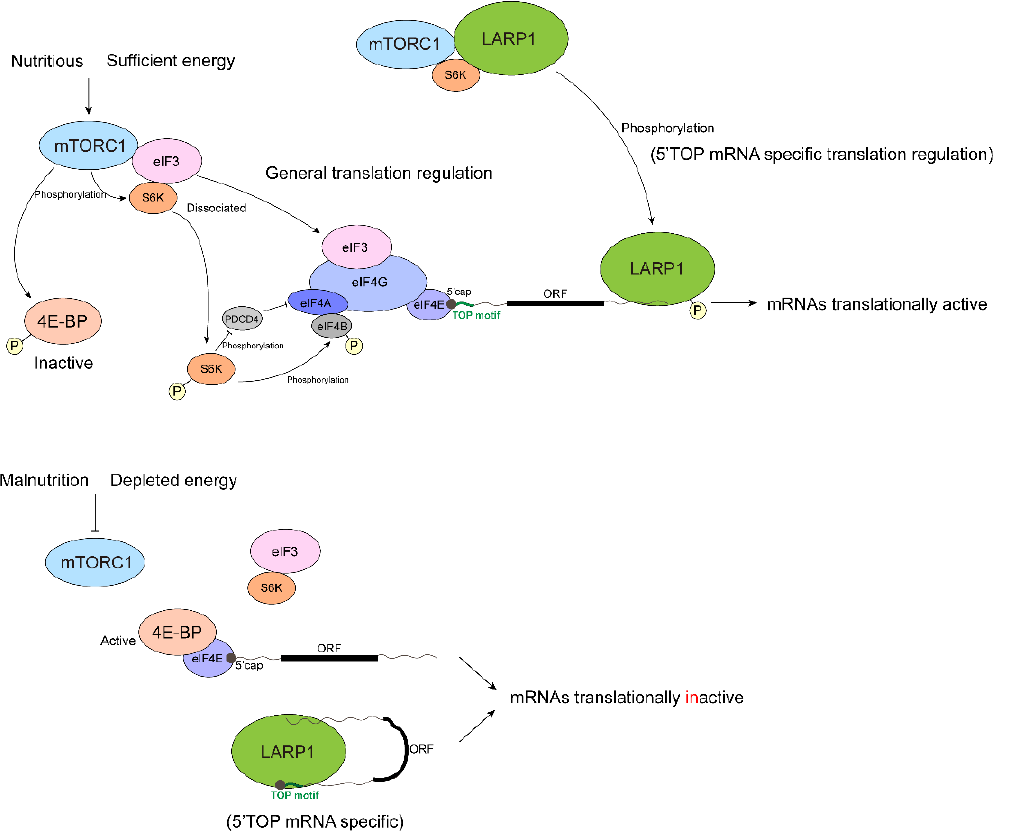
Figure 3. S6K and 4E-BP in mRNA translation. When mTORC1 is activated, 4E-BP is phosphorylated and inactive, and LARP1 is phosphorylated and binds to the 3′ UTRs of RP mRNAs, promoting their translation. When mTORC1 is inactivated, 4E-BP binds to eIF4E and inhibits eIF4F complex formation. S6K1 binds to eIF3 complex to block translation initiation. LARP1 directly binds to 5′ caps, 5′ TOP sequences, and 3′ UTRs of RP mRNAs and inhibits their translation.